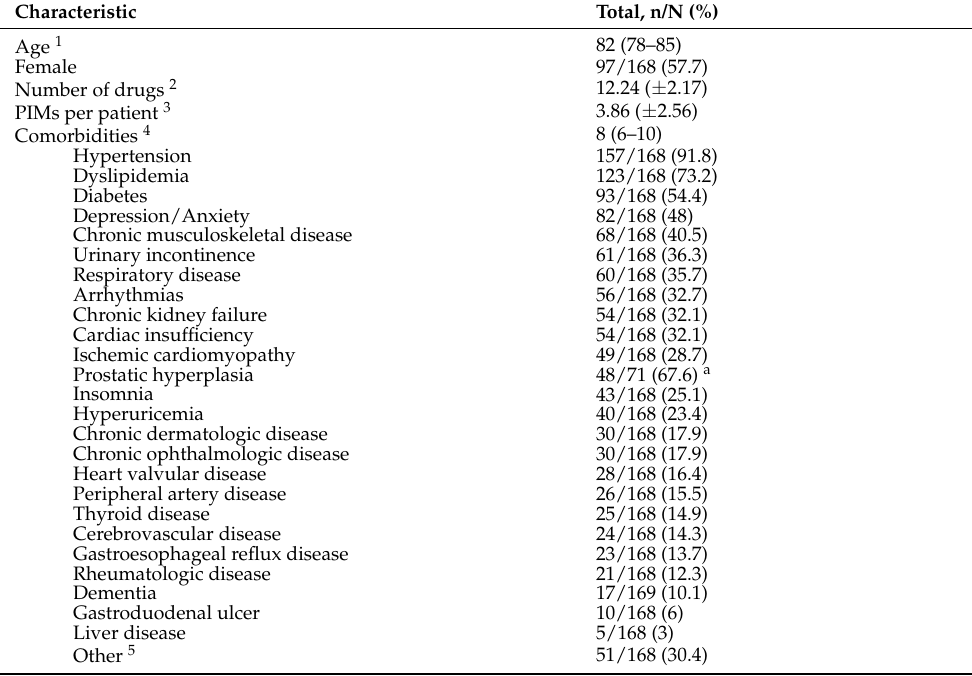
Table 1. Characteristics of excessively polymedicated patients over 75 years